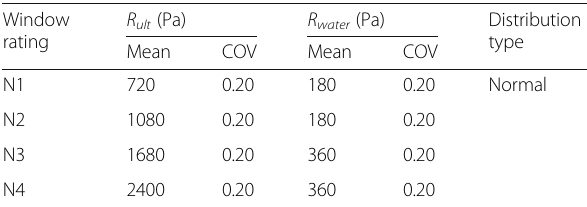
Table 2 Ultimate strength and water penetration resistance of